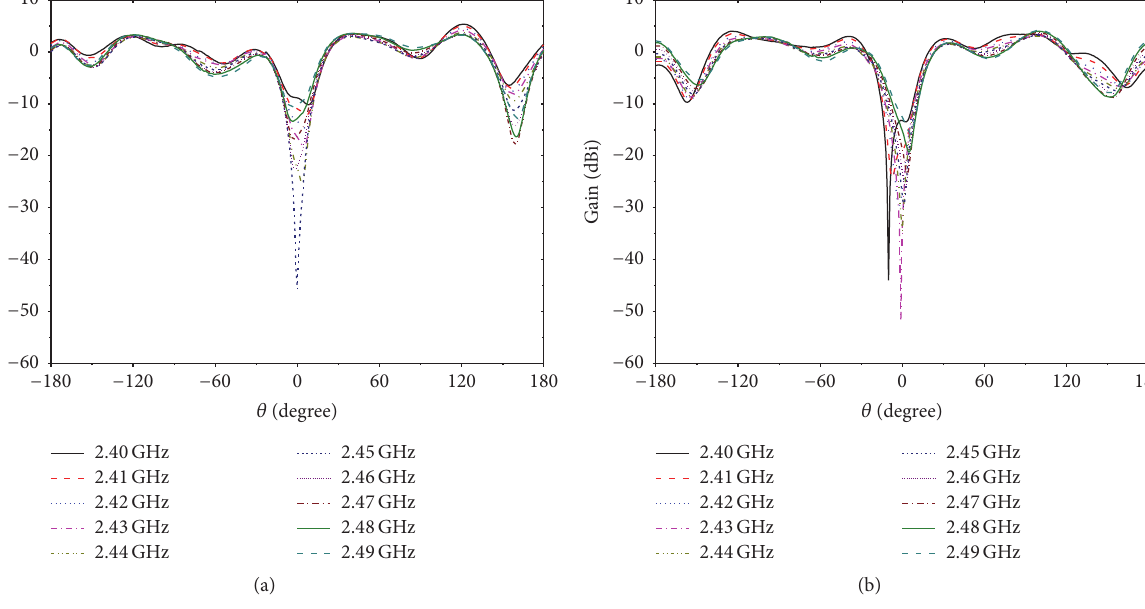
Figure 20: Nulling mode radiation patterns of WiFi band for the examination of beam bandwidth. (a) Results of single frequency goal. (b) Results of multiple frequency average